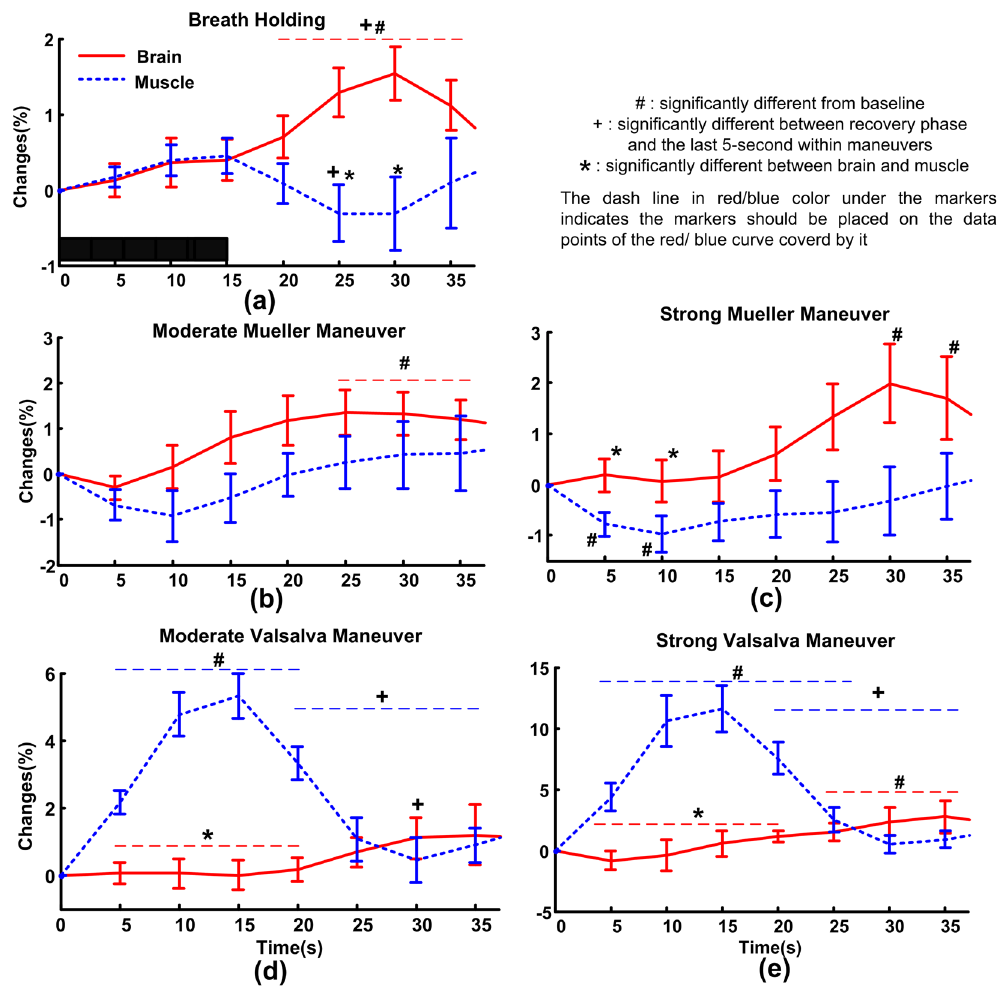
Figure 1. The mean relative changes of blood volume in brain and muscle in each maneuver. The black bar covering 0 to 15 s in ( a ) indicates the period within strain. The error bars are standard error and n = 12.